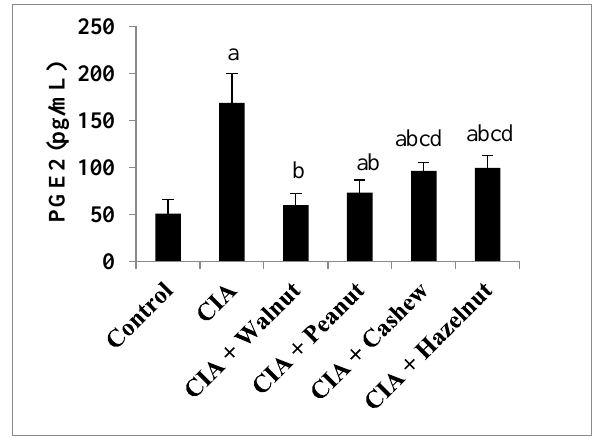
Figure 6. Effect of different nuts’ oil on serum levels of prostaglandin-E2 (PGE2) in adjuvant-induced arthritis (AIA) rat. Model: One-way analysis of variance (ANOVA) with a statistical significance assumed at p ≤ 0.05 followed by Tukey’s HSD post hoc test for statistically significant p -value. Data are presented as mean ± SD for n = 6 rats/groups. a: Significantly different from the control rats. b: Significantly different from the adjuvant-induced arthritis (AIA) model rats. c: Significantly different from AIA + walnut oil. d: Significantly different from AIA + peanut